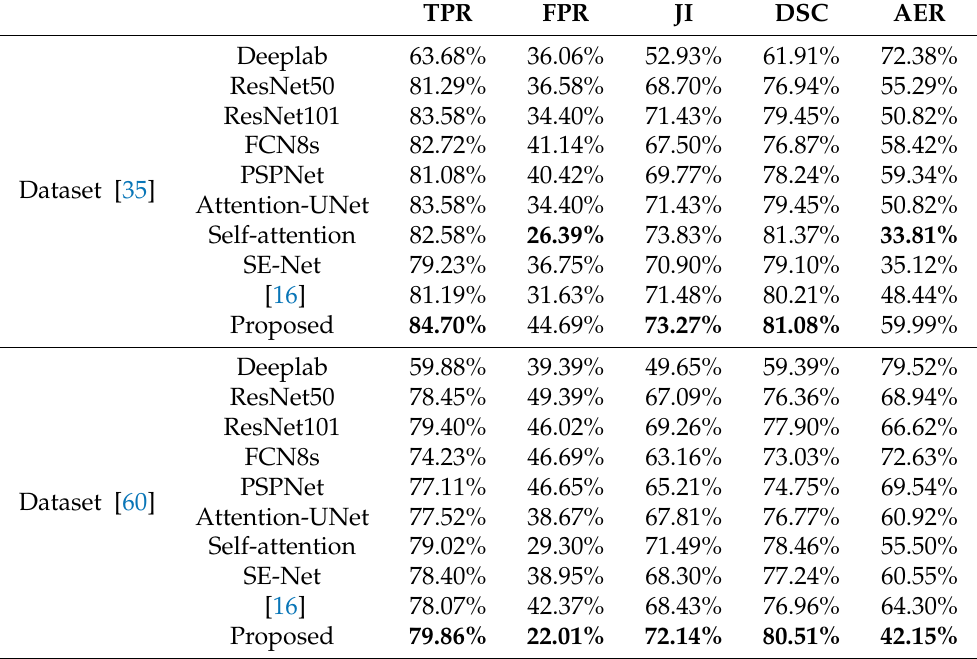
Table 5. Results of Two-class Semantic Segmentation on Dataset [35] and Dataset